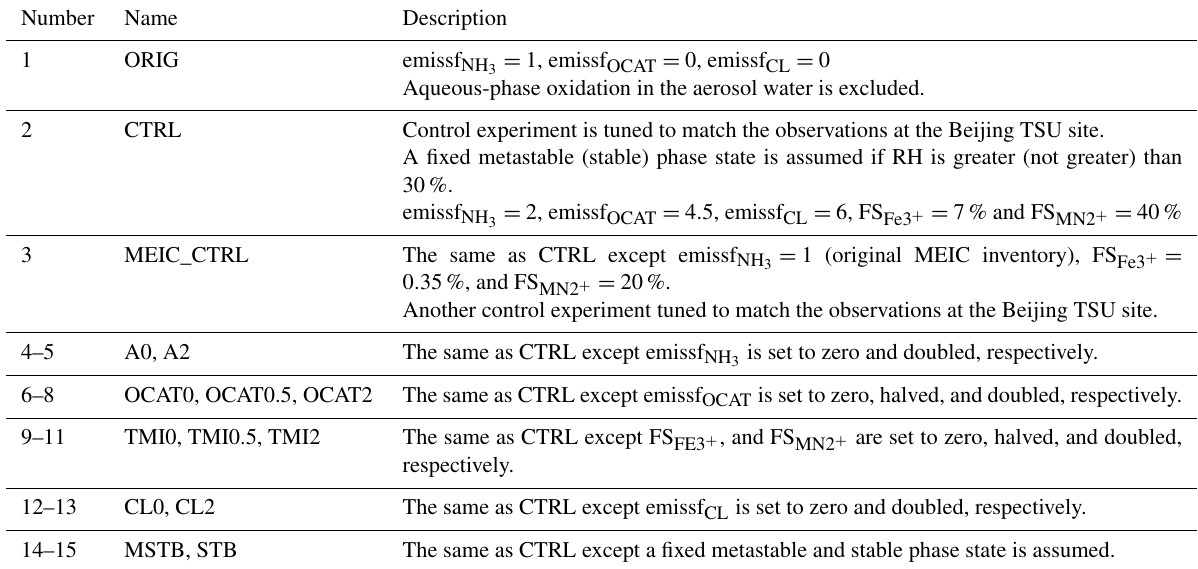
Table 2. Description for different scenarios in this